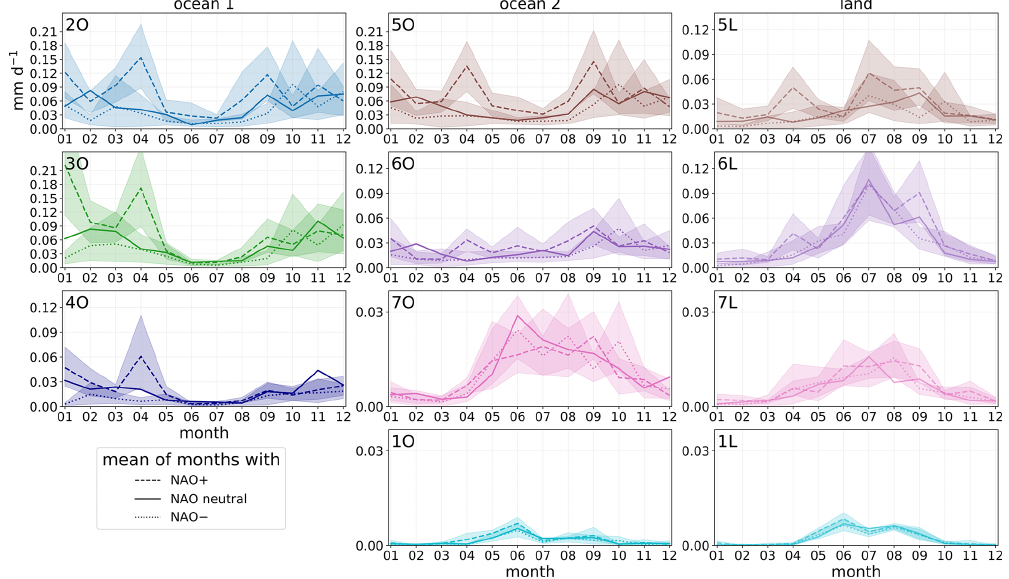
Figure 10. Mean annual cycle of contributing moisture sources distinguishing between months with NAO indices above or equal to the 75th percentile (NAO + ), below or equal to the 25th percentile (NAO − ), and those in between (NAO neutral) for the different clusters. The same thresholds as in Fig. 9b were chosen. Shaded areas represent the 95% confidence interval of the mean of months for the highest and lowest NAO index quartiles (February 1979–May 2017). The legend for the used cluster abbreviations is in Fig. 8a and